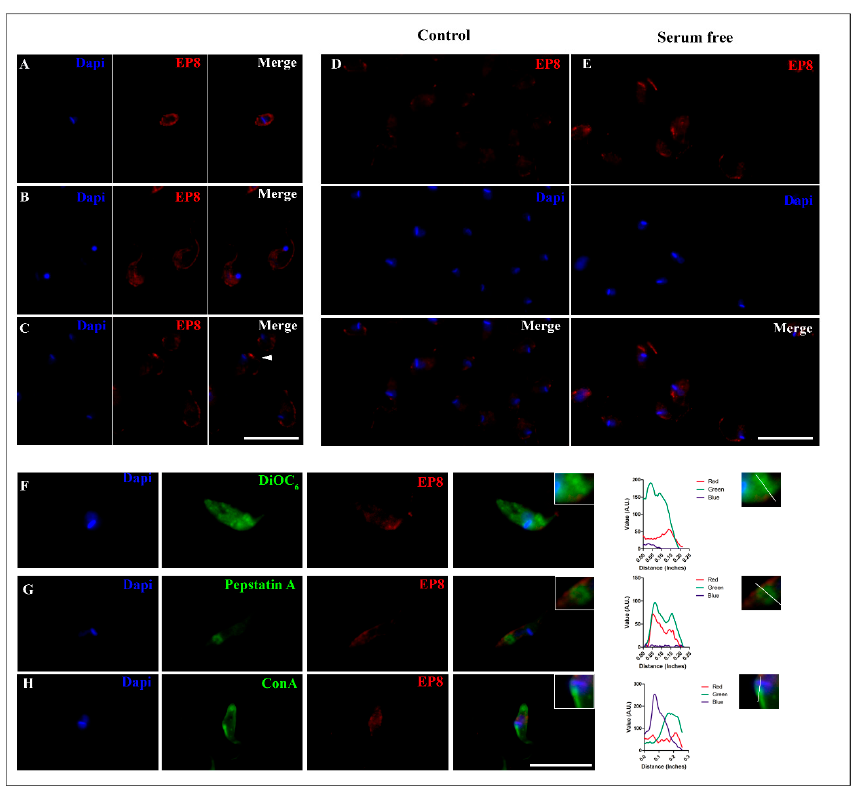
Figure 5. Immunofluorescent subcellular localization of the T. cruzi PS-like protein. A single z-plane image of a representative parasite of different forms of T. cruzi , ( A ) amastigote ( B ) trypomastigote and ( C ) epimastigote immunolabeled with anti-EP8 (red) and DAPI to label nuclei and kinetoplast (blue). White arrowhead shows an immunolabeled concentration signal near the flagellar pocket. Increased signal of PS-like protein in epimastigotes from control conditions in 10% FBS (Control; ( D )) to serum deprivation for 24 h ( E ). Cytolocalization of EP8 with the ER stained with DiOC6 ( F ), intracellular vesicles marked with Cathepsin B ( G ) and the flagellar pocket ( H ). Fluorescence intensity plot of each channel (Red, Green, and Blue) were performed, tracing a line from the posterior to the anterior region of the parasite for each organelle dye. Scale bar = 10 μ m.